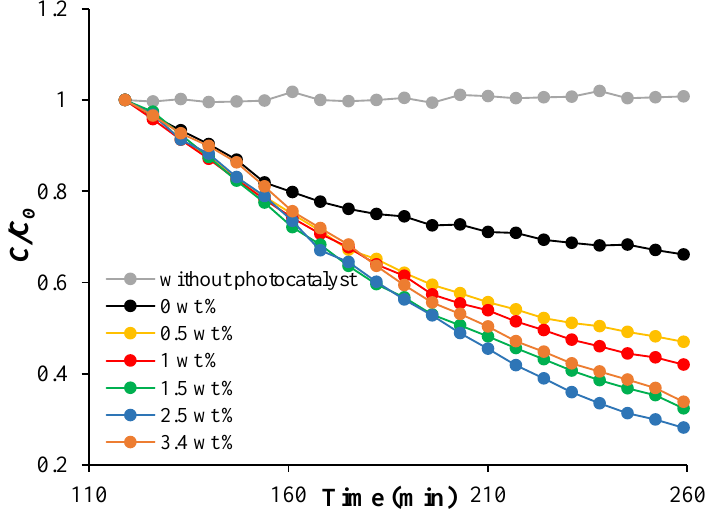
Figure 9. ARS photodegradation versus time for [PP@-TiO 2 ] A , different [PP@AA-TiO 2 ] A photocatalysts and without photocatalyst under visible light.